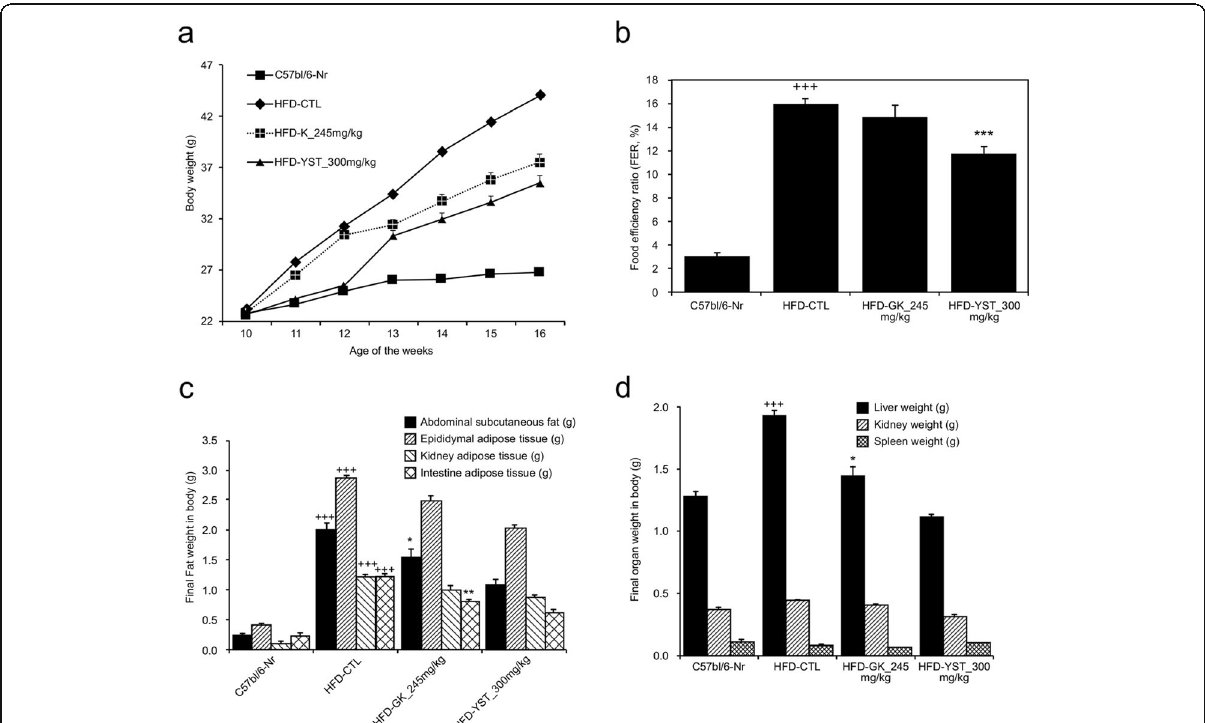
Fig. 1 Effects of YST extract in high-fat diet (HFD)-fed mice after 6 weeks of YST administration. a Body weight, b food efficiency ratio, c fat weight, d organ weight. Normal diet group: C57bl/6 J-Nr; HFD-control group: HFD-CTL; HFD plus 245 mg/kg Garcinia cambogia extract: HFD-GK; HFD plus 300 mg/kg YST: HFD-YST. The results are expressed as mean ± SEM ( n = 6). + p < 0.05, ++ p < 0.01, and +++ p < 0.001 compared with C57bl/6 J-Nr, and * p < 0.05, ** p < 0.01, and *** p < 0.001 compared with